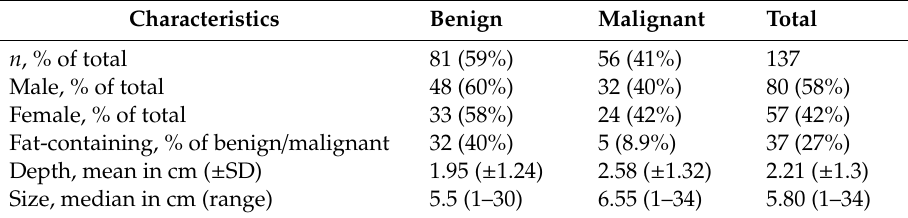
Table 1. Patient and tumor characteristics.